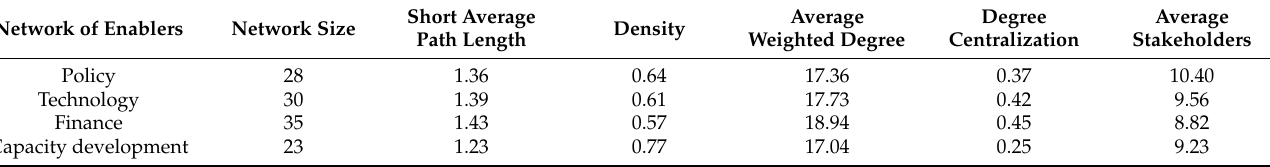
Table 6. Network-based metrics per enabler.